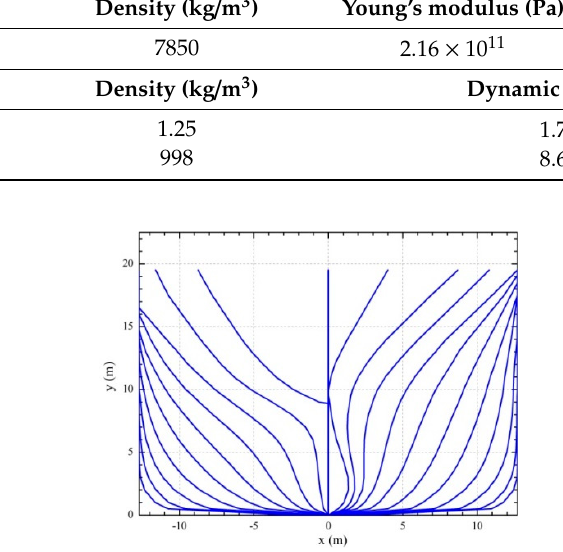
Table 5. Parameters of materials.